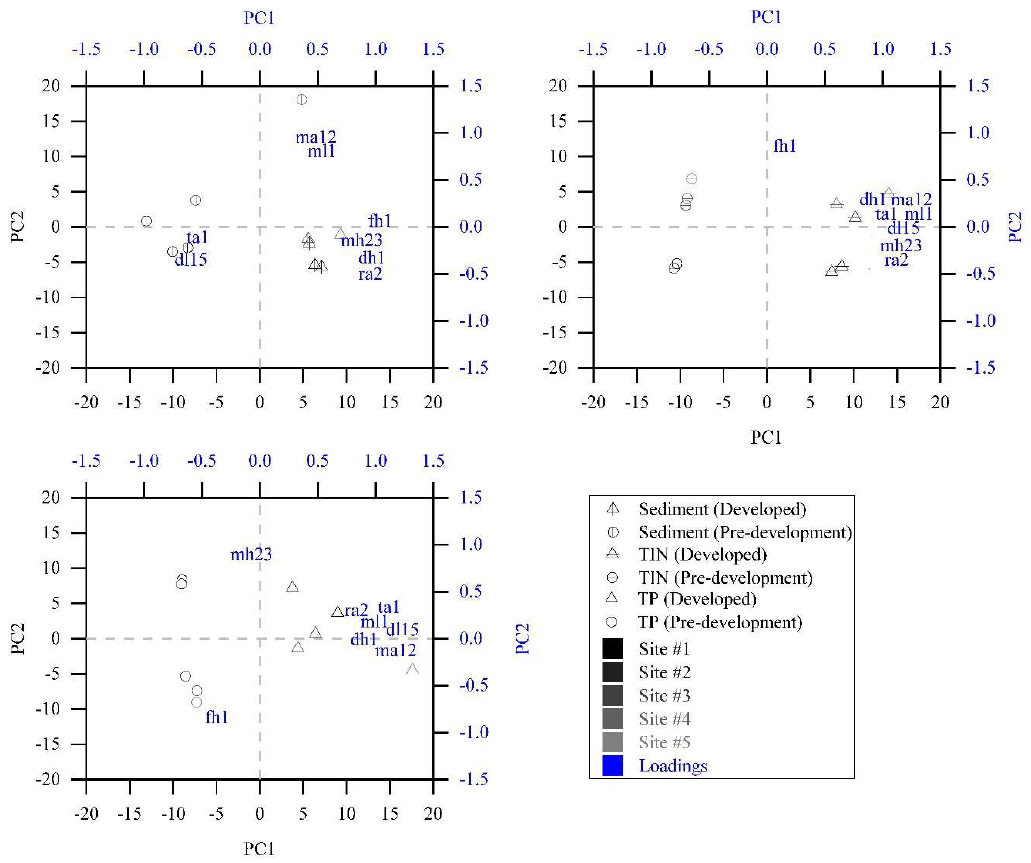
Figure 3. Bi-plot showing scores generated from simulated pre-development and observed developed loading data at five gauging sites in Hinkson Creek, Missouri, USA. Loadings of indices with the greatest absolute loadings for eight loading sub-components are also shown. PC1 and PC2 are principal component axes. Definitions of indices are shown in Table 5. Loading indices that overlapped were slightly offset to improve readability. Total inorganic nitrogen is TIN, and total phosphorus is TP.